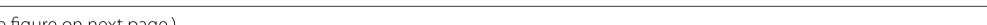
figure on next Fig. 5 TRAIL overexpression partially rescued the inhibitory effect of Tetrandrine on osteoclastogenesis. A The mRNA expression of c-Fos, CTSK, DC-STAMP, NFATc1 and TRAP in BMMs in rescue experiment was detected by RT-qPCR. B Western blotting demonstrated the expression of NFATc1, TRAP and CTSK in BMMs in rescue experiment. C The number and area of TRAP-positive cells, the bone resorption pits and F-actin formation in rescue experiment; Scale bar in TRAP staining and immunofluorescence image All experiments were carried out in triplicate. The results were presented as mean compared with the control